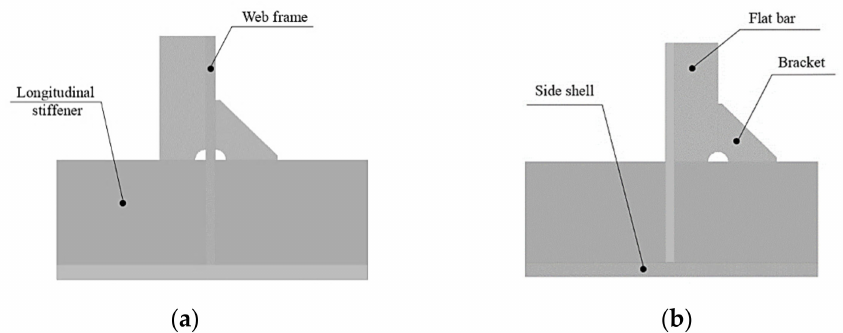
Figure 3. Schematic detail description: ( a ) Det3 ( b ) Det6 .